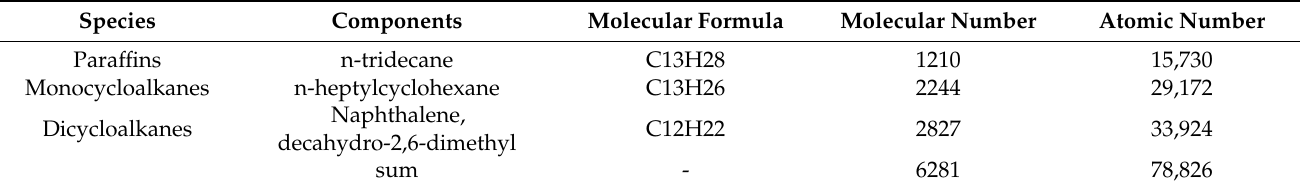
Table 1. The number of molecules and atoms included in the rocket kerosene model.